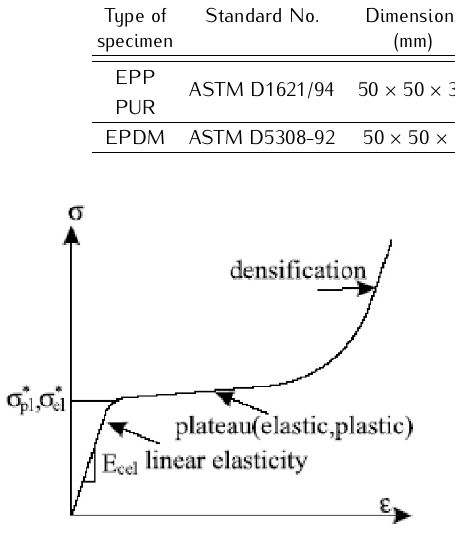
Figure 1. A typical stress-strain curve of a foam